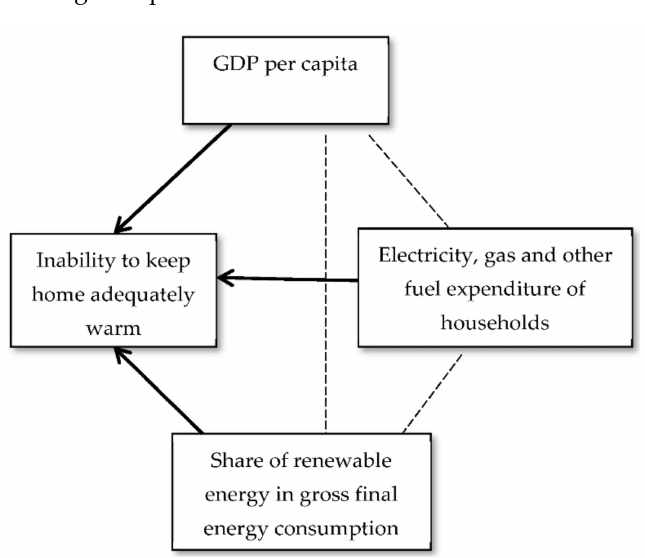
Figure 1. Framework of correlations between variables. Source: own